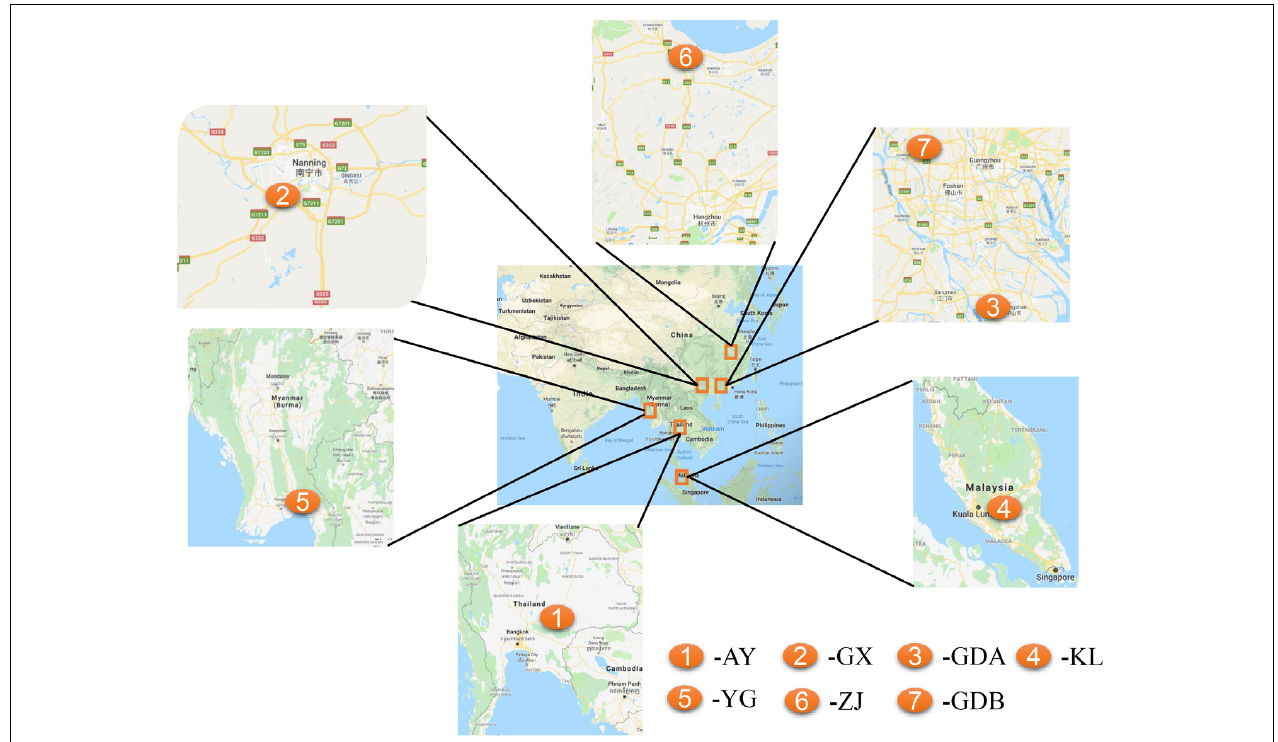
FIGURE 1 | Map of sampling sites of the seven Macrobrachium rosenbergii populations.